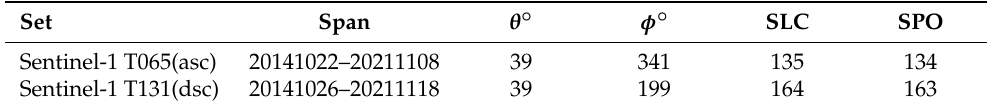
Table 1. Sentinel-1 SAR data used in this study, where θ is incidence and φ is azimuth angles, SLC is number of SLC images, and SPO is number of range/azimuth offset